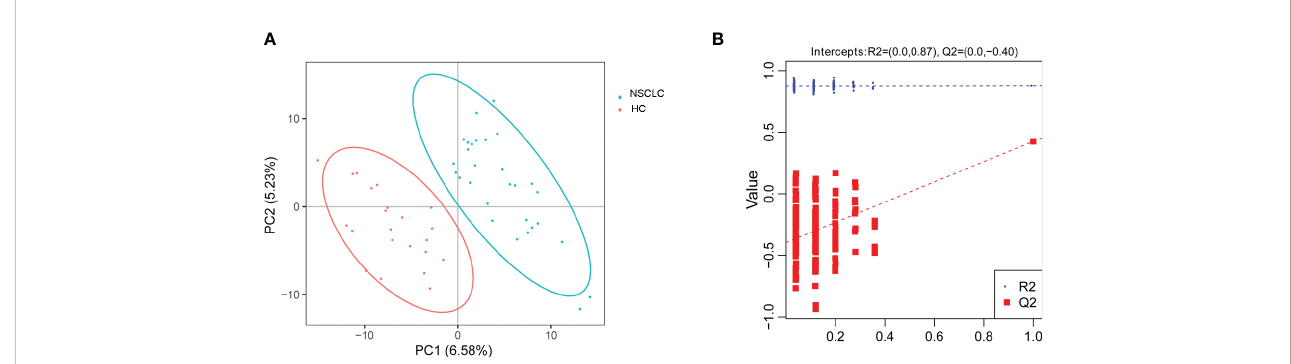
FIGURE 5 Principal component analysis. (A) PLS-DA score plot shows the difference in metabolites between groups. (B) Comparison of real and permuted model parameters in validation tests.